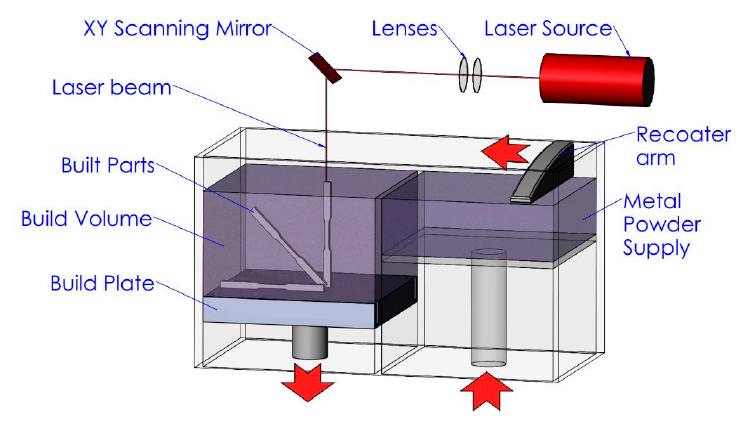
Figure 1. Typical Laser Powder Bed Fusion (L-PBF) process configuration.